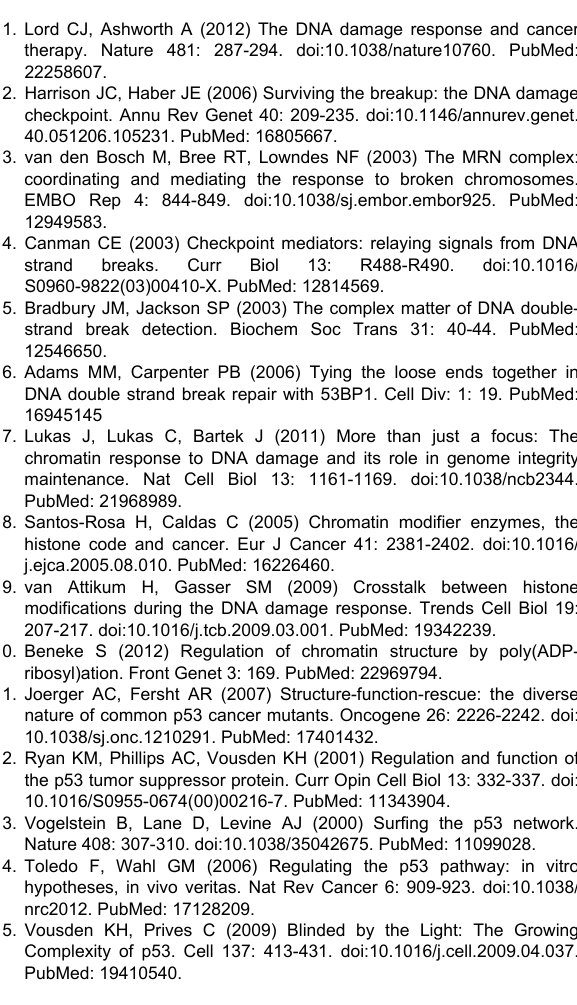
Figure S3. Interaction between tBRCT-MDC1 and the p53- CTD peptides. Representative snapshots from Molecular Dynamics simulations of the tBRCT-MDC1 and the p53-CTD peptides (a) Ac-K382 and pS392, (b) Ac-K382 or (c) pS392. (d) Unmodified CTD peptide.tBRCT-MDC1 is shown in surface representation and p53-CTD peptide is shown as a blue ribbon. (TIF) Movie S1. Overlap of the double modified peptide (blue) and the unmodified peptide (red). Note that whereas both peptides had the same initial position in space, the unmodified peptide detaches with time while the modified peptide is bound to MDC1-tBRCT and that the acetylated K382 and especially phosphorylated S392 are important for the interaction. (MPG) Movie S2. The double modified peptide. (MPG) Movie S3. The unmodified